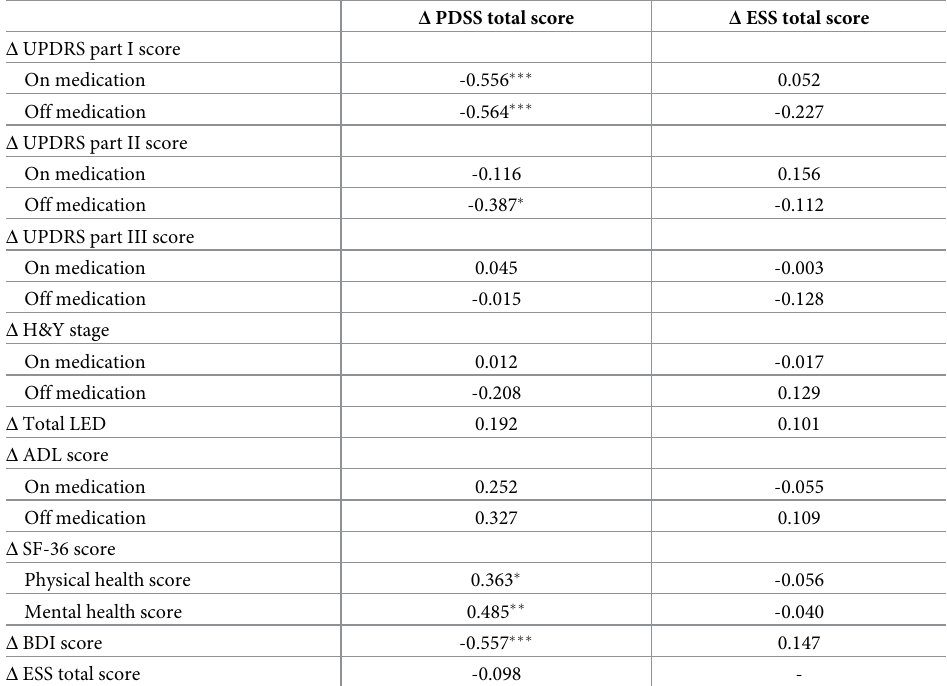
Δ , changes from baseline to post-DBS year 3; PDSS, Parkinson’s disease sleep scale; ESS, Epworth sleepiness scale; UPDRS, Unified Parkinson’s disease rating scale; H&Y, Hoehn & Yahr; LED, Levodopa equivalent dose;